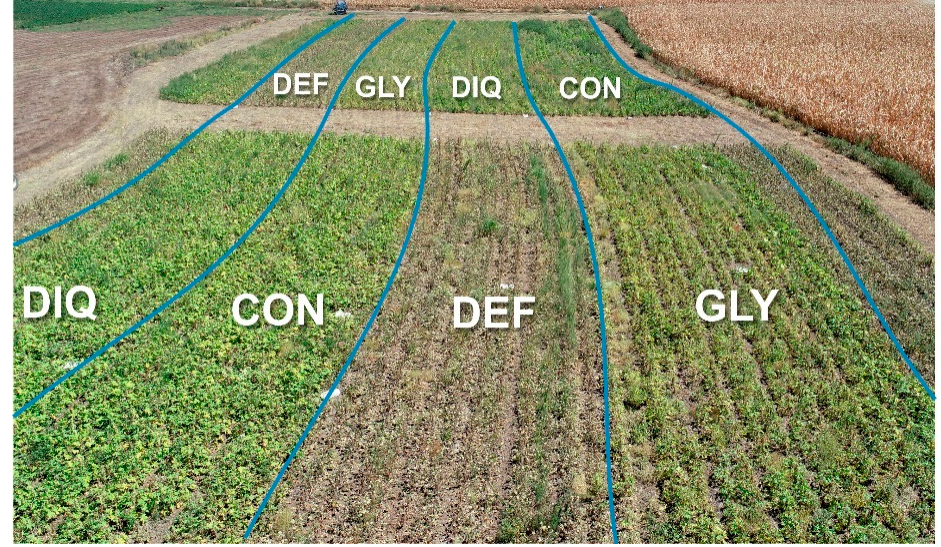
Figure 2. Field view on 30 August 2021, three days after applying harvest aids in GLY and DEF treatments. (GLY = Glyphosate, DEF = Spotlight ® , DIQ = Diquat and CON = Control).